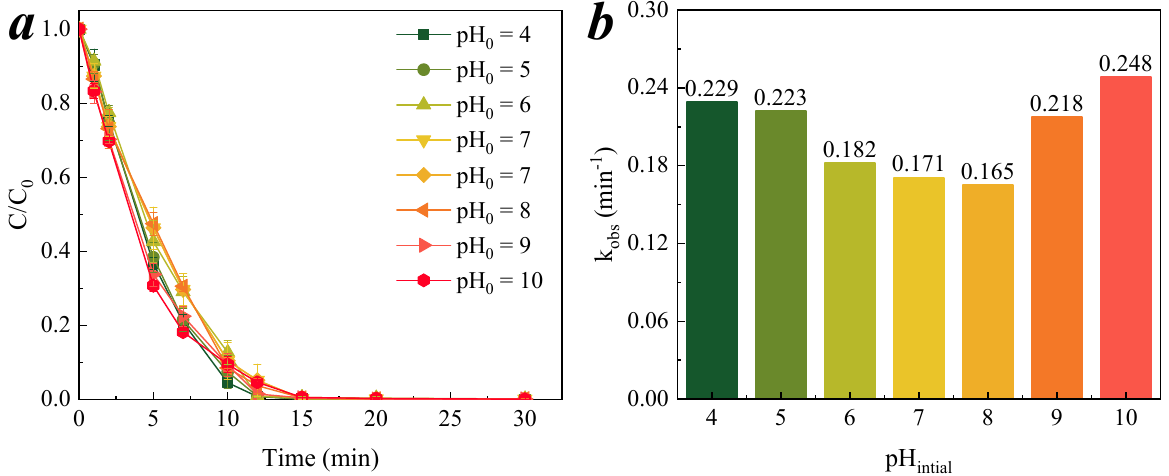
Figure 7. Effect of initial pH on nitrobenzene degradation and reaction kinetics of CM catalytic ozonation. ( a ) Degradation of nitrobenzene in different initial pH conditions; ( b ) the corresponding rate constants k obs for the catalytic ozonation of nitrobenzene at different initial pH. Conditions: [O 3 ] = 0.5 mg/L, [nitrobenzene] 0 = 0.064 mM.